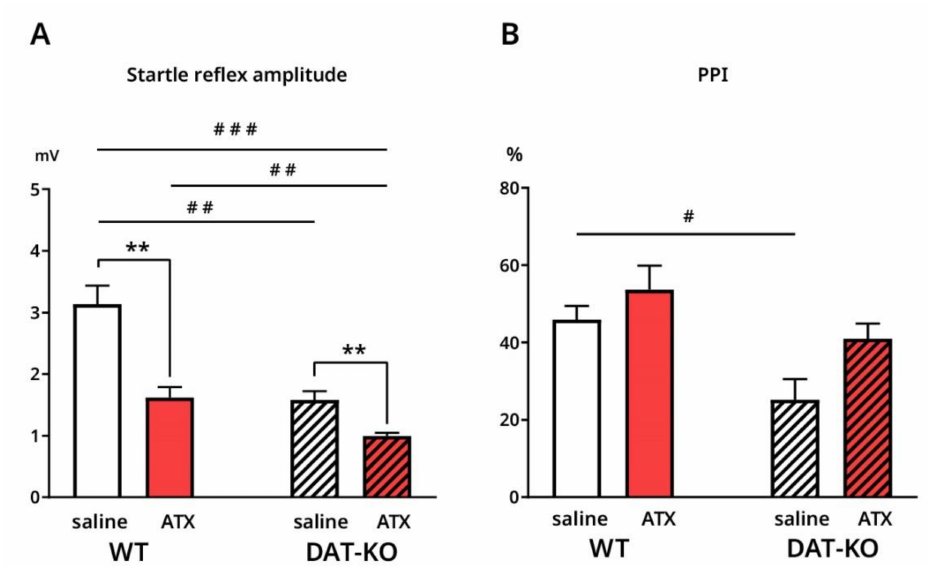
Figure 3. Amplitude of startle reflex and PPI index in DAT-KO and WT rats after saline and after ATX ( A , B ). # p < 0.05; **, ## p < 0.01; ### p < 0.001; Brown-Forsythe and Welch ANOVA, Holm–Sidak’s multiple comparisons